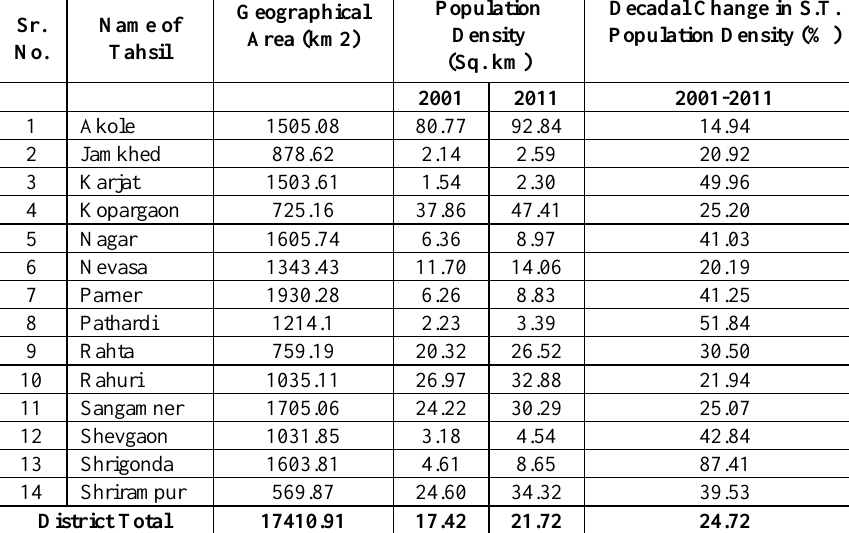
Source: District Census Handbook, Ahmednagar (M.S.) (2001 & 2011) Table 2. Changes in Tribal Population Density in Ahmednagar District (2001-2011)